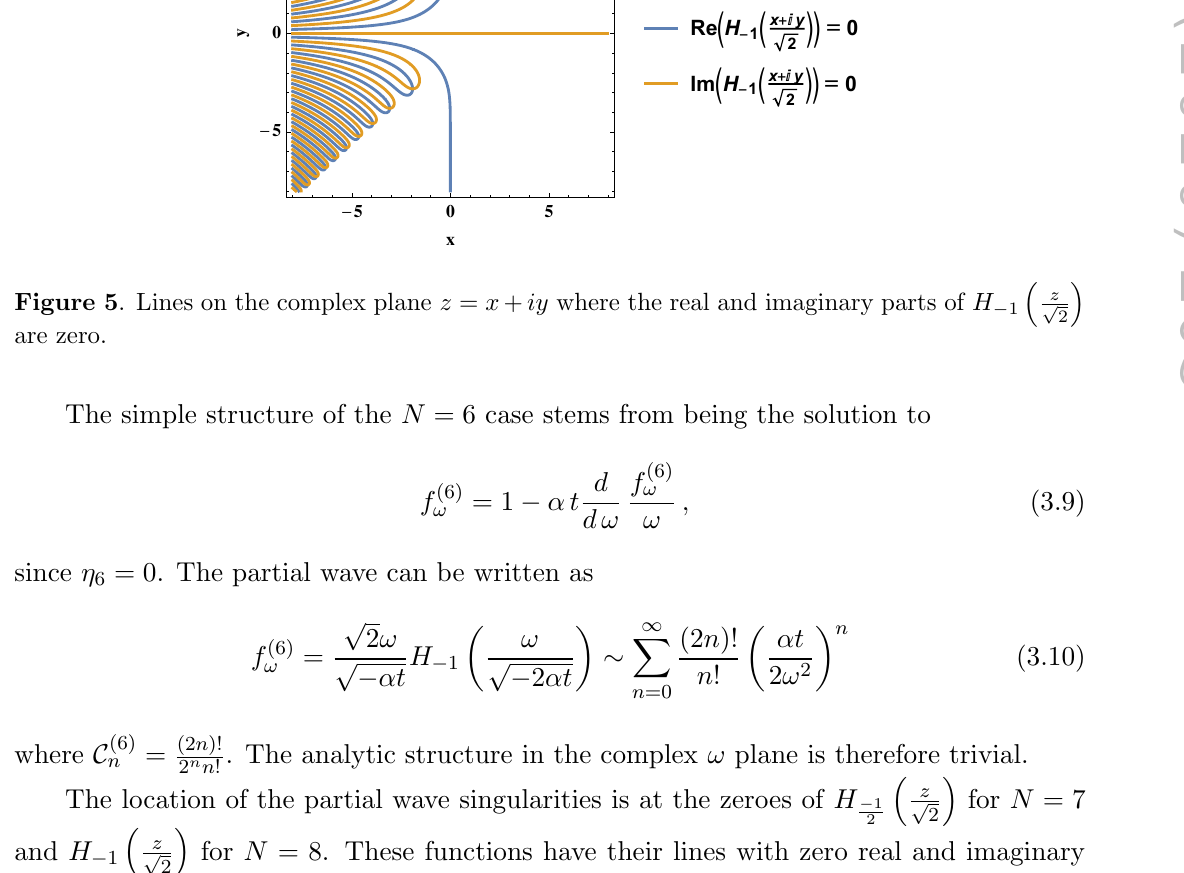
Figure 4 . Lines on the complex plane z = x + iy where the real and imaginary parts of H are zero.